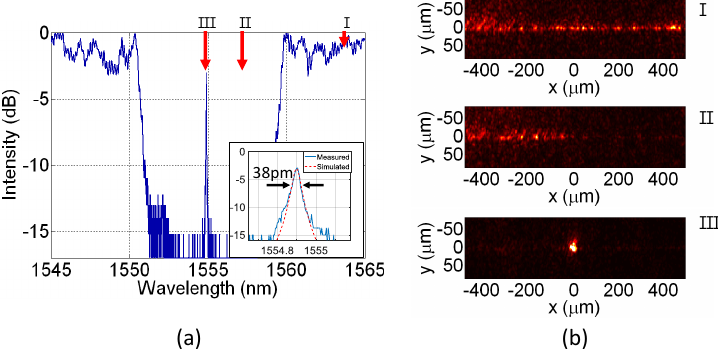
Figure 6. ( a ) Measured transmission spectrum of a π -phase shifted grating with a length of 200 µ m; ( b ) near-infrared (NIR) images of vertically scattered light from the grating and access waveguides, corresponding to spectral positions detailed in ( a